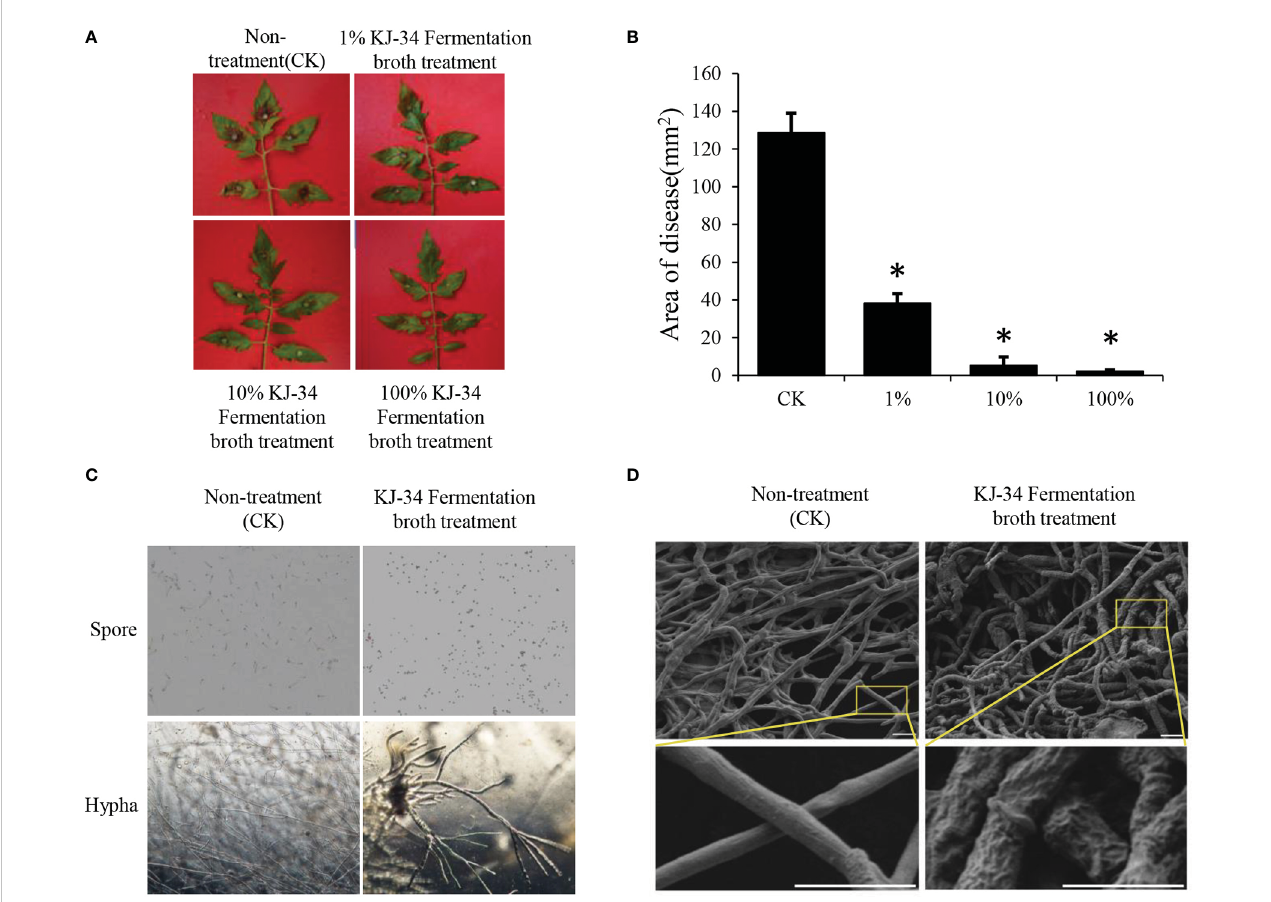
FIGURE 2 Biological control effect of KJ-34 fermentation fi ltrate against B. cinerea . (A) Tomato leaves were sprayed with the KJ-34 fermentation fi ltrate before inoculation with B . cinerea . Tomato leaves were treated with PDB as a control 5 days prior to pathogen inoculation. (B) Quanti fi cation of the lesion area of leaves pretreated with different concentrations of KJ-34 fermentation fi ltrate. Error bars representthe standard error of mean ( n = 18). Asterisks indicate a signi fi cant difference ( p < 0.05) according to the least signi fi cant difference test. (C) The effect of KJ-34 fermentation fi ltrate on spore germination and hyphal growth of B . cinerea . (D) The changes in mycelium morphology after KJ-34 fermentation fi ltrate treatment were observed with a scanning electronic microscope (bar = 2 m